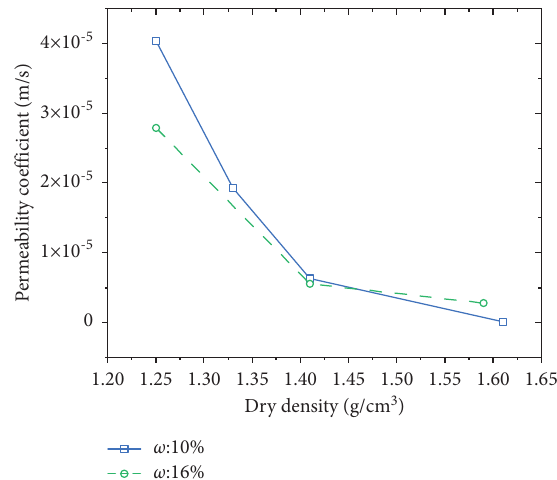
Figure 11: Relationship curve between permeability coefficient and dry density of remolded loess with different water